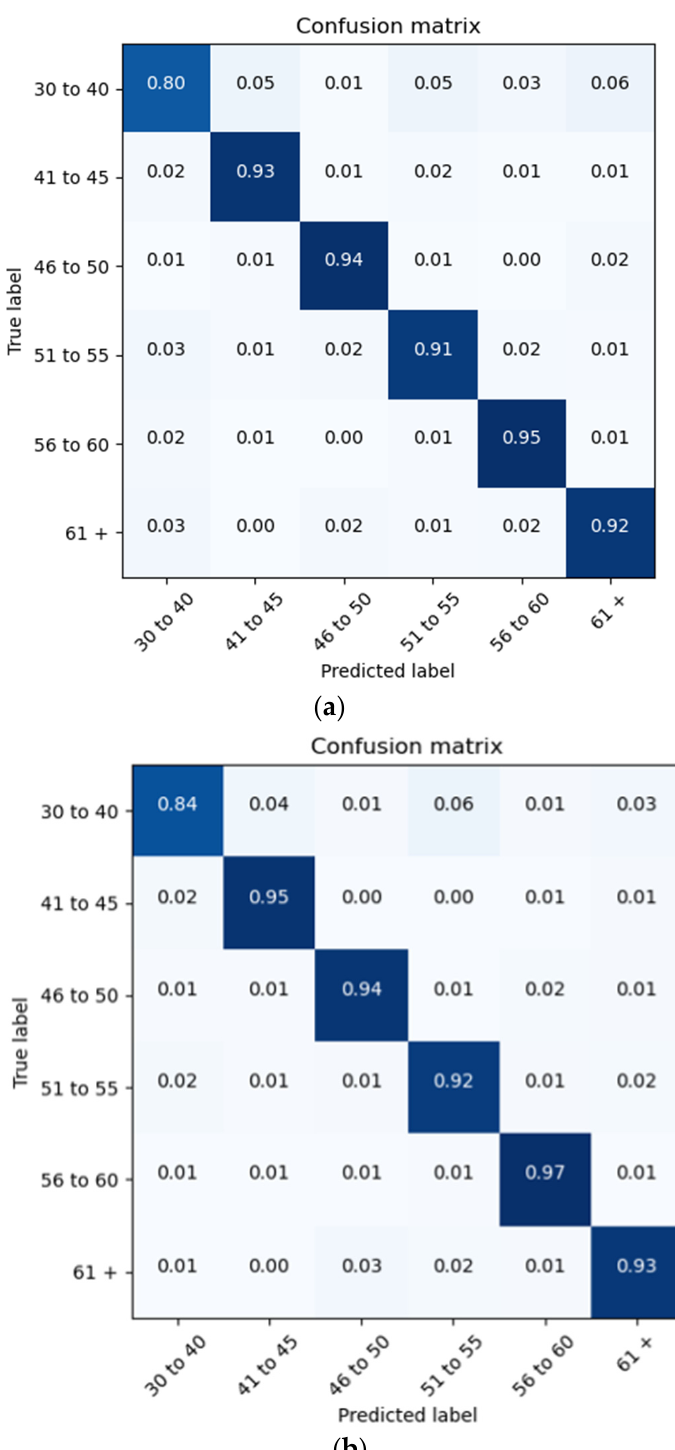
Figure 19. Confusion Matrices Generated from: ( a ) BLSTM raw data testing; ( b ) BGRU raw data